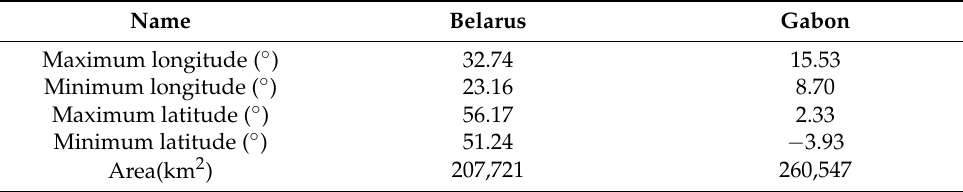
Table 2. Parameters of Belarus and Gabon.